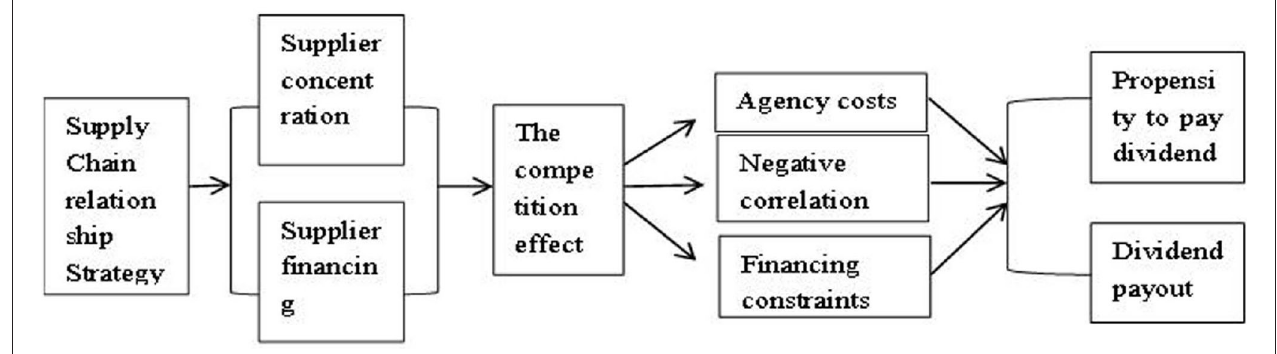
FIGURE 1 | Relationship and mechanism of supplier relationship strategy and cash dividend.